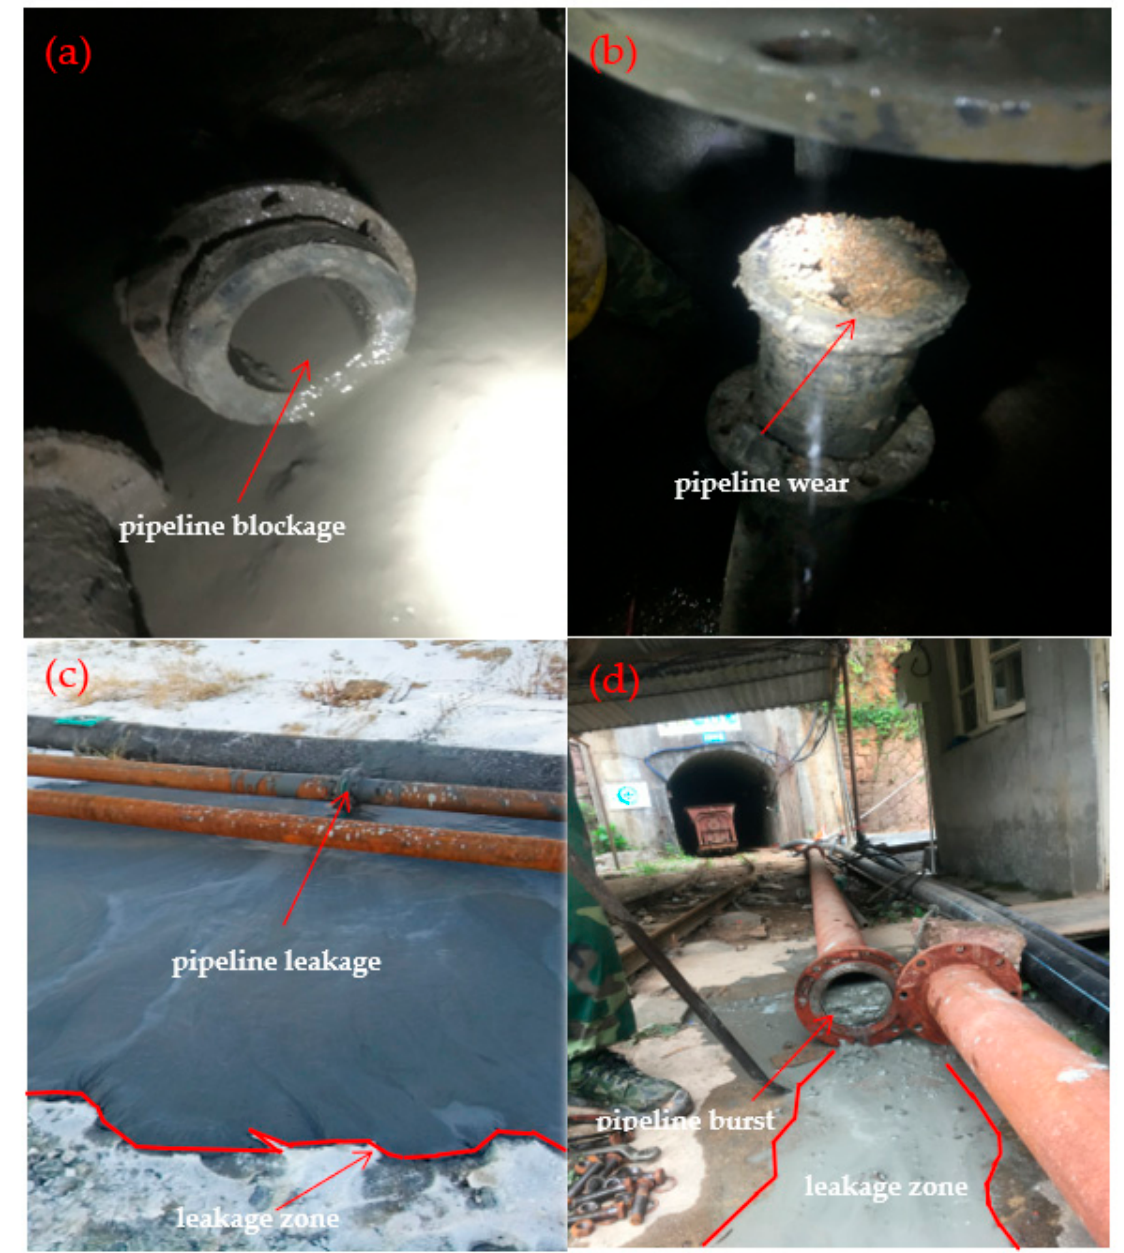
Figure 2. Backfilling pipeline failure photos: ( a ) pipeline blockages; ( b ) pipeline wear; ( c ) pipeline leakage; ( d ) pipeline burst.